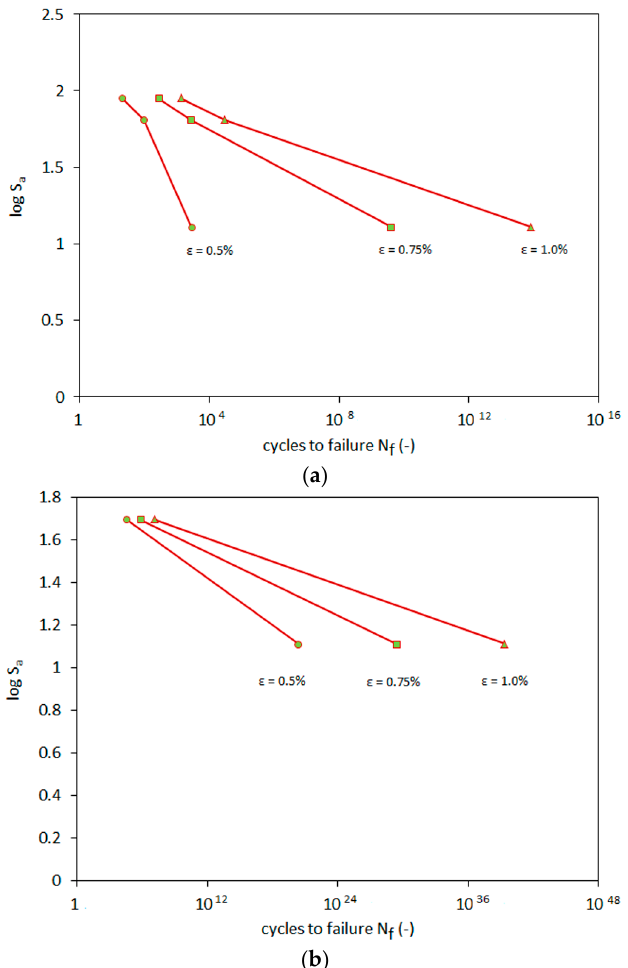
Figure 13. S-N plots for the RCA in various strain to failure conditions at effective stresses of ( a ) p’ 0 = 45 kPa and ( b ) p’ 0 = 90 kPa.